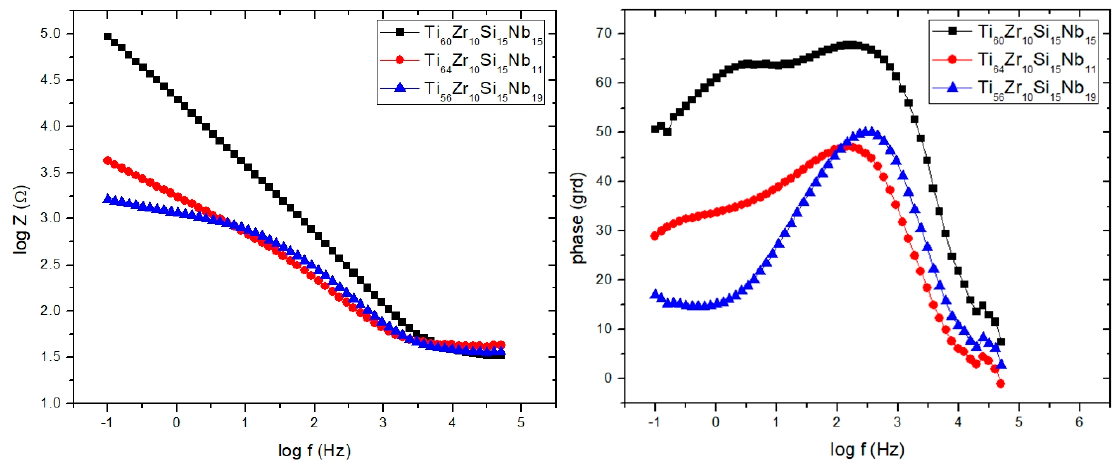
Figure 17. Bode plots for NaCl 0.9%.